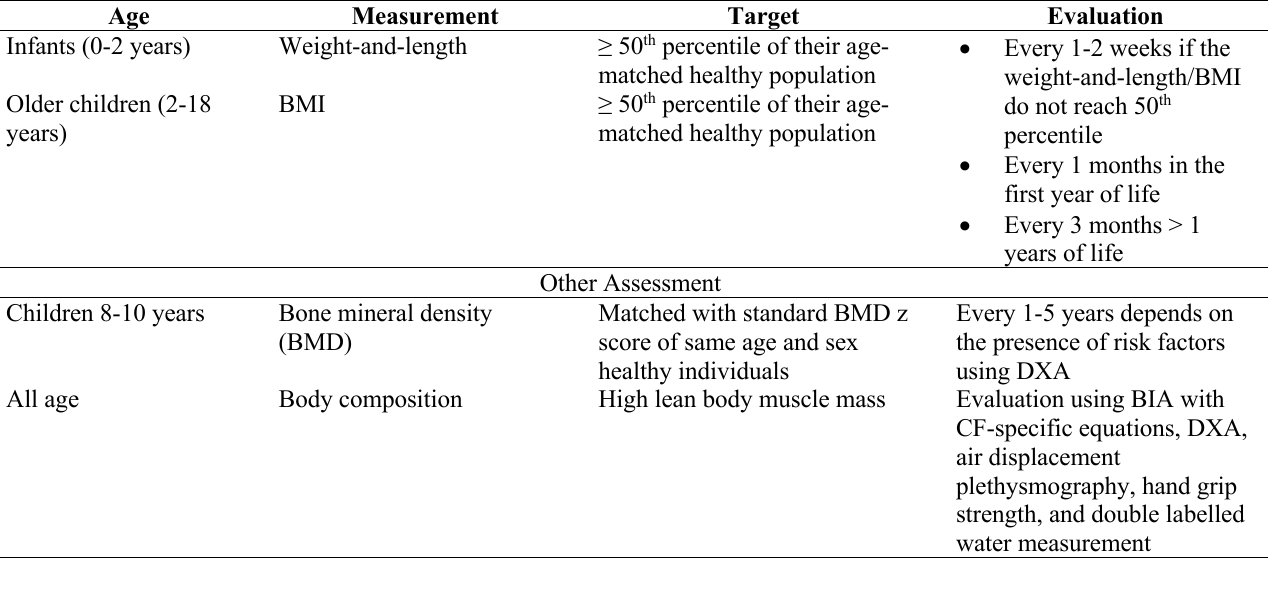
Table 4. The recommended PERT dosages